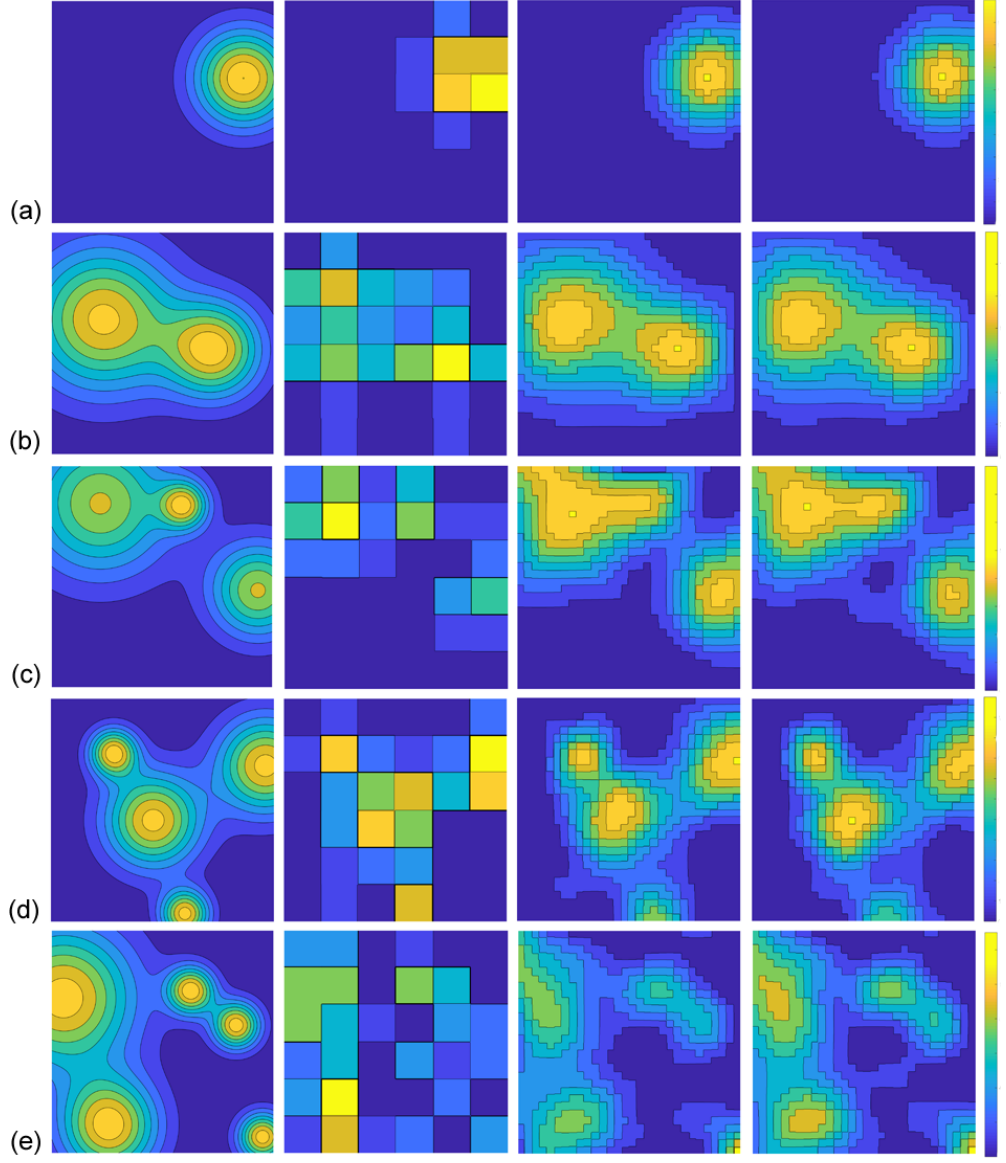
Figure 3. Original test maps (first column) and corresponding maps reconstructed with the NNLS (second column), LTD (third column), and MC (fourth column) algorithms, showing (a) one source, (b) two sources, (c) three sources, (d) four sources, and (e) five sources, respectively.